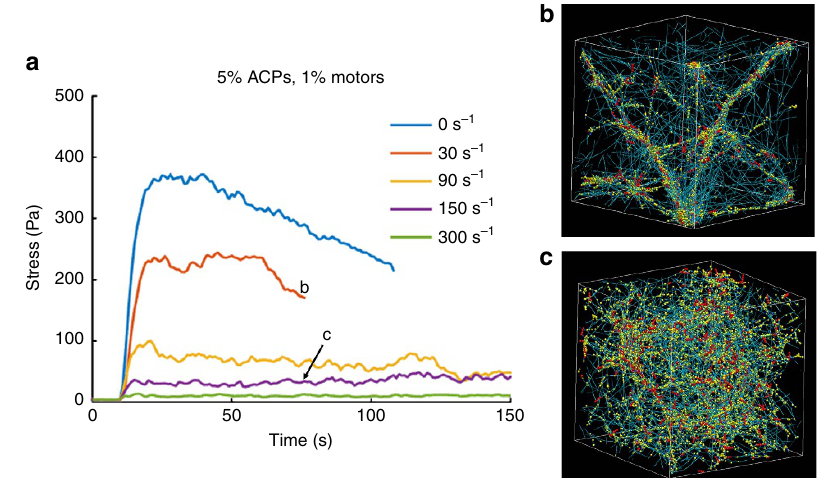
Figure 2 | Time evolution of internal stresses. ( a ) Typical stress versus time profiles in simulated cytoskeletal networks with active motors, actin turnover and ACP binding dynamics. These results are from 3D networks with 25 m M actin, 1% motors and 5% ACPs at the specified actin turnover rates (legend). At low turnover rates, the stress peaks and then dissipates corresponding to network aggregation, whereas at high turnover rates the stress is lower but remains stable, indicative of a relatively homogenous network. b , c show the network morphologies in the corresponding time and configuration indicated in a . Teal, yellow and red are actin filaments, ACPs and motors,